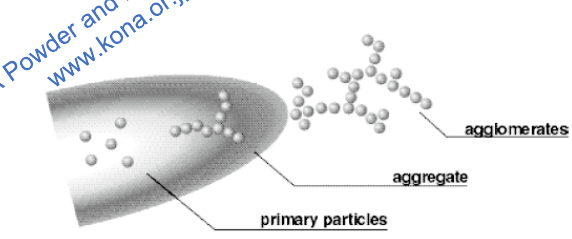
Fig.2 Synthesis of Fumed Silica particles using Flame Process